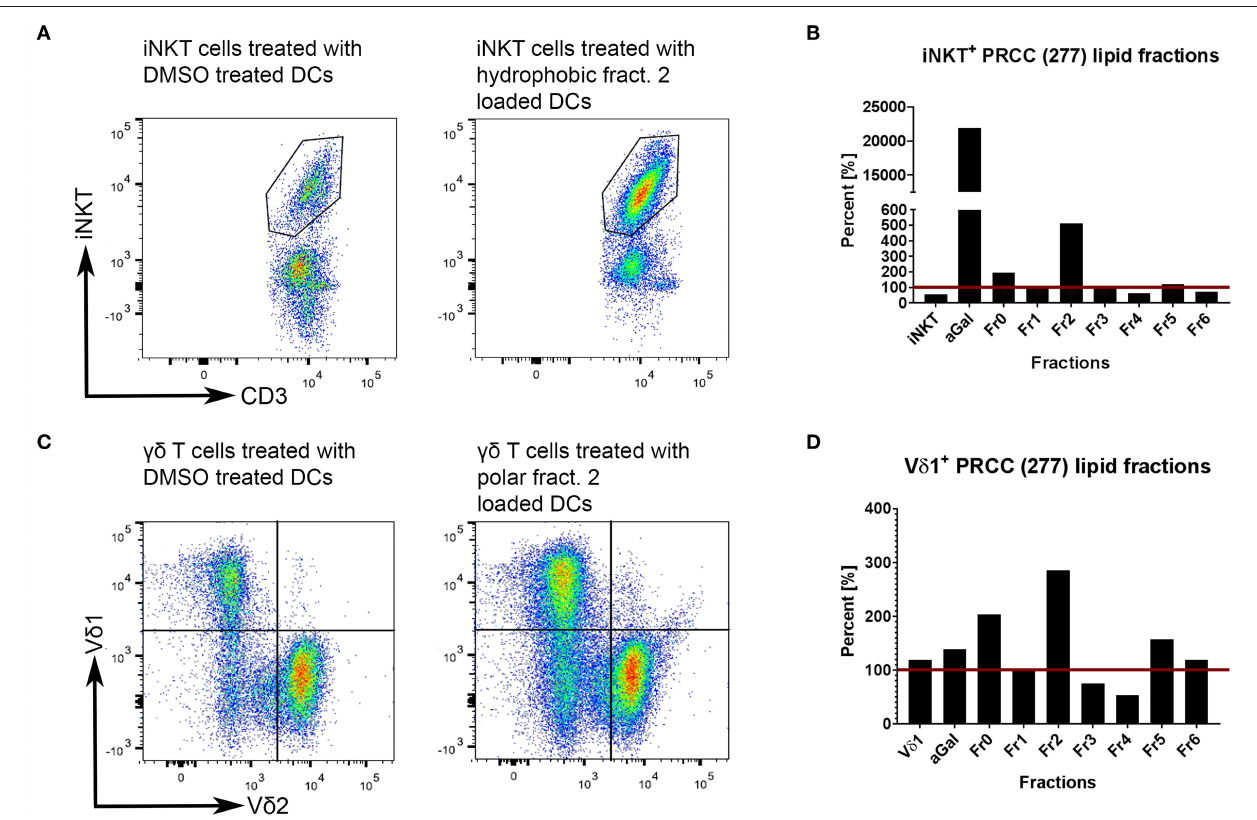
FIGURE 6 | Tumor own lipids (277) induce proliferation of unconventional T cells from healthy donors. Lipid-loaded DCs were co-cultivated with purified iNKT (A,B) or γδ T cells (C,D) . DMSO was used as negative control, α -GalCer as positive control. Untreated iNKT and V δ 1 cells are shown to assess whether DMSO-treated immature DCs have an effect on the respective T cell population. (A,B) After three stimulations with lipid-loaded DCs, lipid fraction 2 showed the strongest induction of proliferation of healthy donor 2-derived iNKT cells compared to DMSO control (defined as 100%, red line). DMSO has a small stimulating effect on iNKT cells. (C,D) After three stimulations, lipid fraction 2 is able to induce the proliferation of healthy donor 4-derived V δ 1 + T cells compared to DMSO control (defined as 100%, red line). DMSO has no stimulating effect on V δ 1 + T cells. The results for all lipid fractions and all donors are shown in Supplemental Figure 8